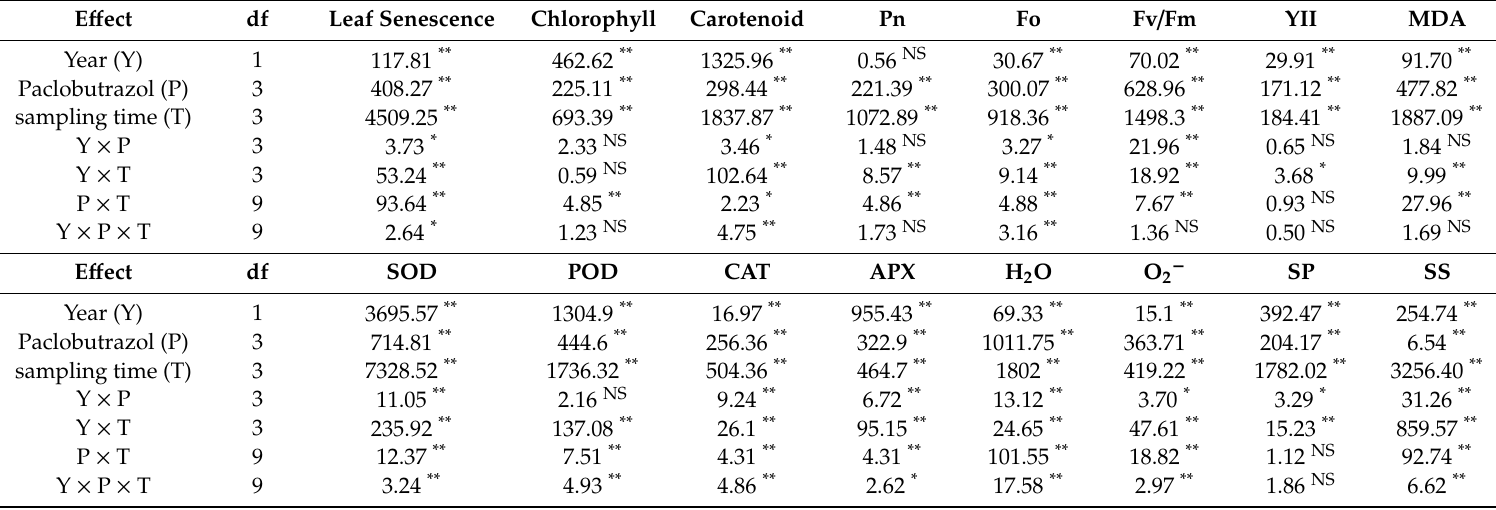
Table 3. Result of ANOVA on the e ff ects of the year (Y), paclobutrazol treatments (P), and sampling times (T) on leaf senescence, photosynthetic pigments, net photosynthetic rate, chlorophyll fluorescence parameters, antioxidant enzymes, reactive oxygen species, and lipid peroxidation, soluble protein (SP) and soluble sugar (SS) contents in